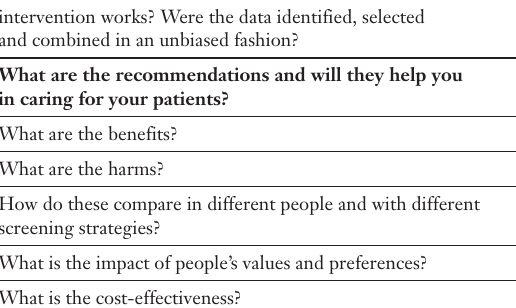
User’s Guides for Guidelines and Rec- ommendations about Screening. (From Barratt et al. [11], with